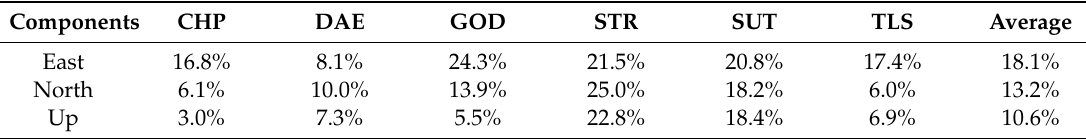
Table 9. Accuracy improvement percentages of frozen variances of the unit weight strategy compared with the ED prior weighting strategy in Multi-GNSS positioning from DoY 201 to 230 in 2019.